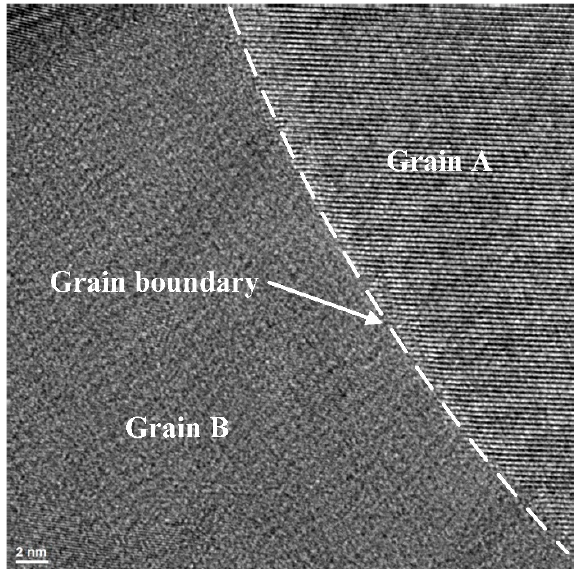
Figure 5. High-resolution TEM photograph of specimen. Different grains, grains’ lattice and grain boundary could be observed.